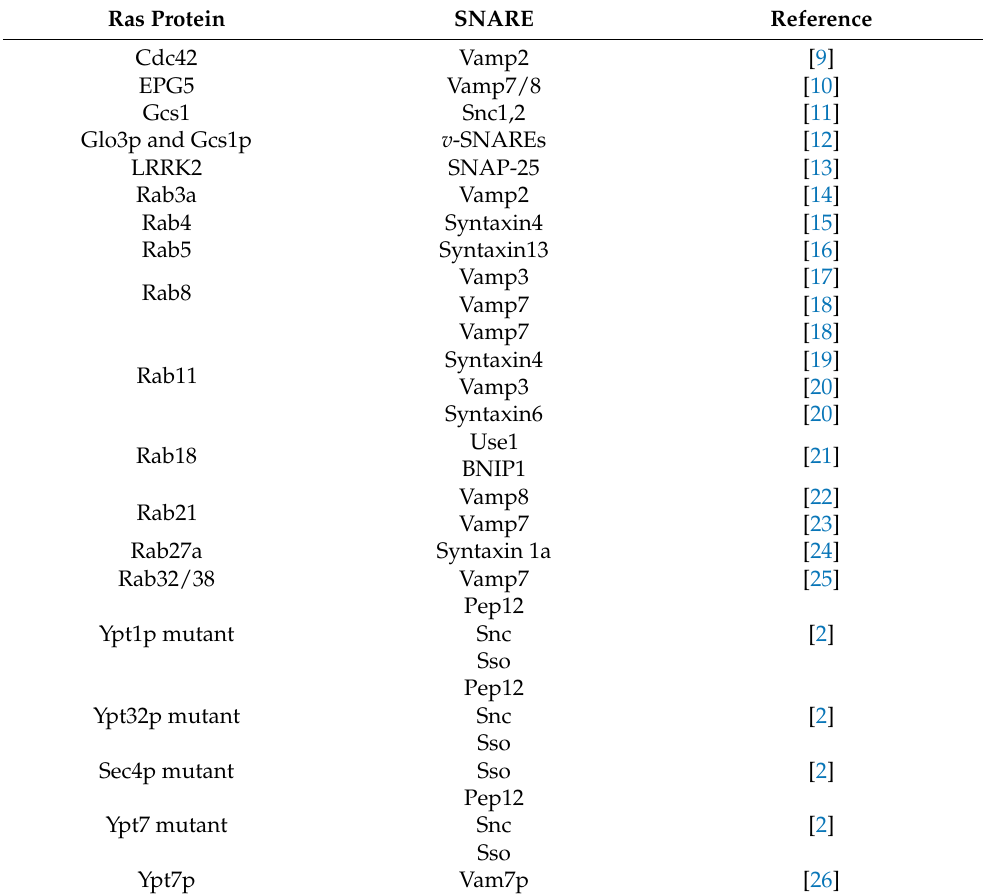
Table 1. Ras and SNARE proteins interact together. Findings regarding the proven interactions between the two classes of proteins are